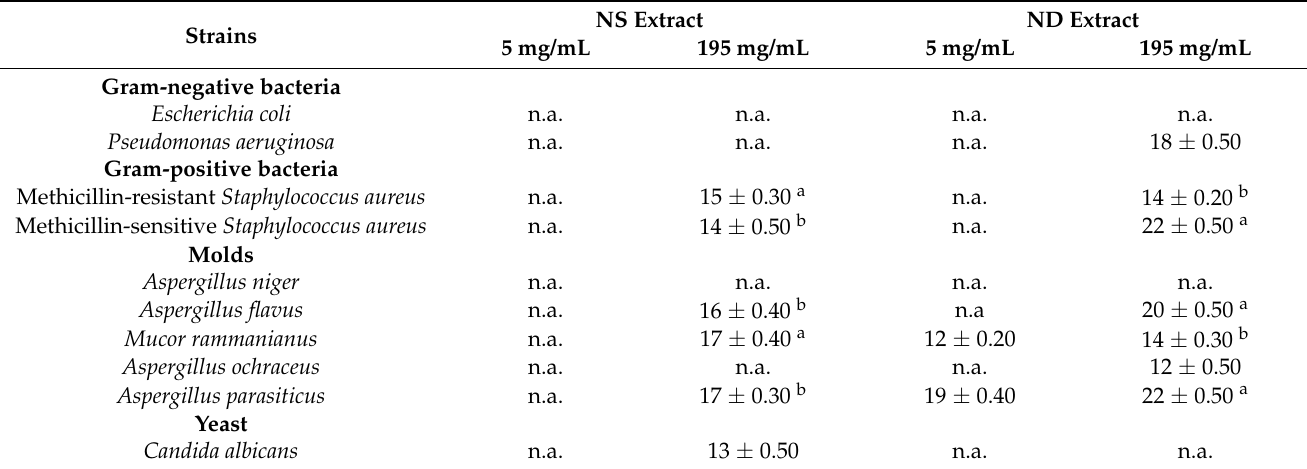
Table 6. Antimicrobial activity of NS ( Nigella sativa L.) and ND ( Nigella damascena L.) extracts (expressed in